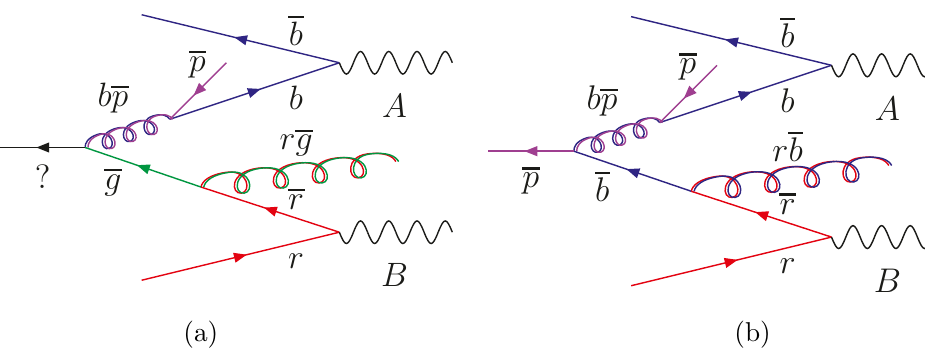
Figure 6 . Treatment of the colour (cid:13)ow in the case of merging: (a) colour (cid:13)ow before correction, (b) colour (cid:13)ow after correction. Here, an in(cid:12)nite number of colours are available (leading-colour approximation) so the label p stands for the new colour